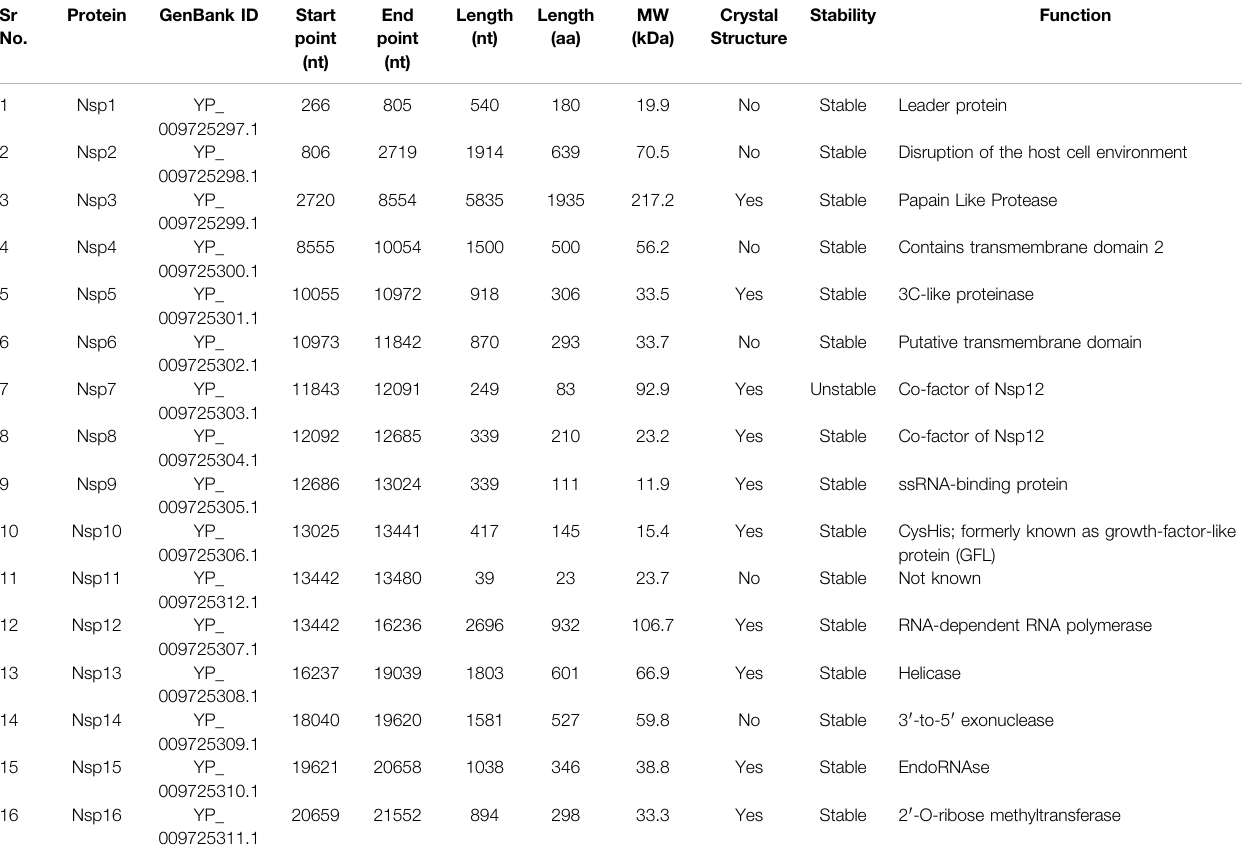
TABLE 1 | Summary of the Non-structural proteins. Sr No.